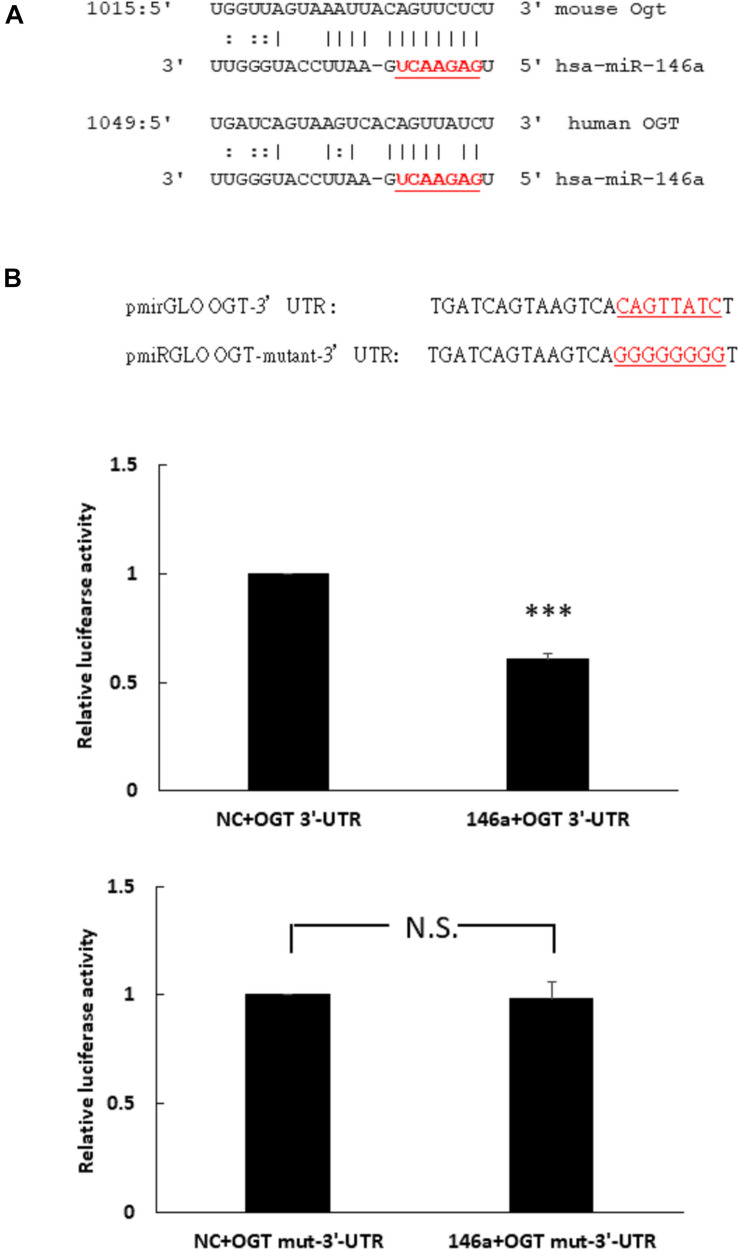
(A,B) Human OGT is a non-canonical target of miR-146a-5p. (A) Bioinformatic miR target analysis identified partial seed sequence match between miR-146a-5p and the 3′-UTR of human OGT mRNA. However, mouse Ogt showed perfect seed sequence homologies between miR-146a-5p and the 3′-UTR of mouse OGT mRNA. (B) A luciferase reporter assay showed that co-transfection of the miR-146a-5p mimic and pmirGLO-OGT-3′-UTR could downregulate the relative luciferase activity to 61% of the control luciferase signal, N = 5, ∗∗∗p < 0.001 compared with the negative control. Co-transfection of the miR-146a-5p mimic and pmirGLO-OGT-mutant-3′-UTR did not alter the relative luciferase activity. N = 5, N.S., not significant, compared to the negative control (NC).